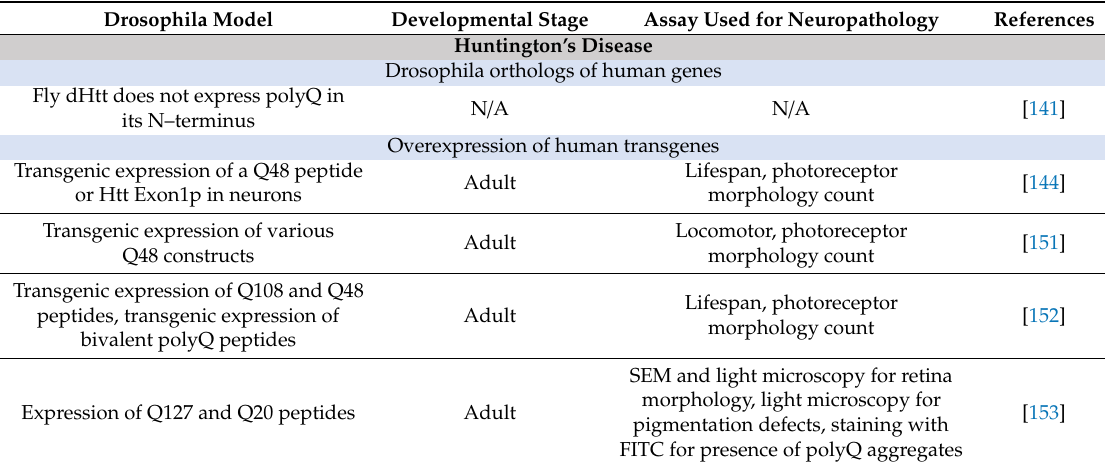
Table 4. Drosophila models of Huntington’s